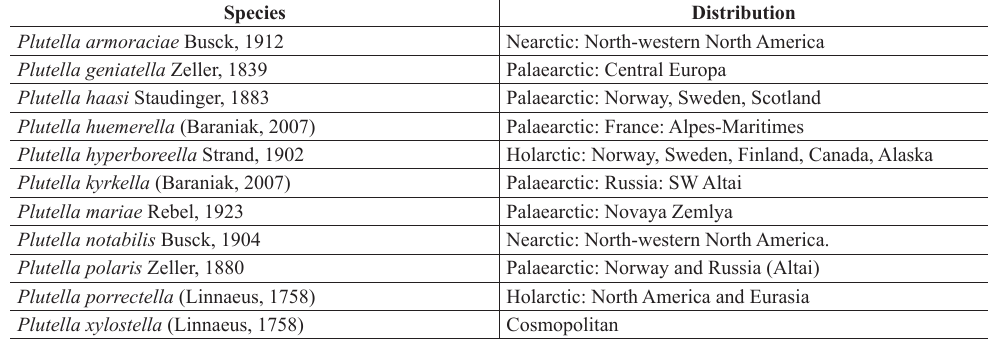
Table 1. Species of Plutella recorded in the Northern hemisphere north of